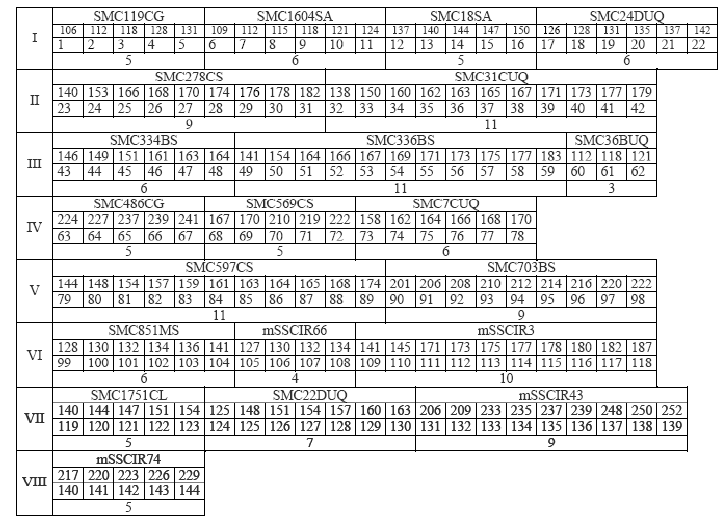
Figure 1. Formulation of 144 microsatellite (SSR) DNA fingerprints-based sugarcane molecular identity. These fingerprints are amplifiable from sugarcane genomic DNA through PCR using one of the 21 simple sequence repeats (SSR) markers listed in Table 1. Within each section (I through VIII shown on the left), name of the SSR marker (row 1), allele size (base pairs) (row 2), sequential order (row 3), and number of allele per marker (row 4) are shown. The presence or absence of each of the 144 SSR DNA fingerprints in a sugarcane cultivar, when combined, constitutes its molecular identity.